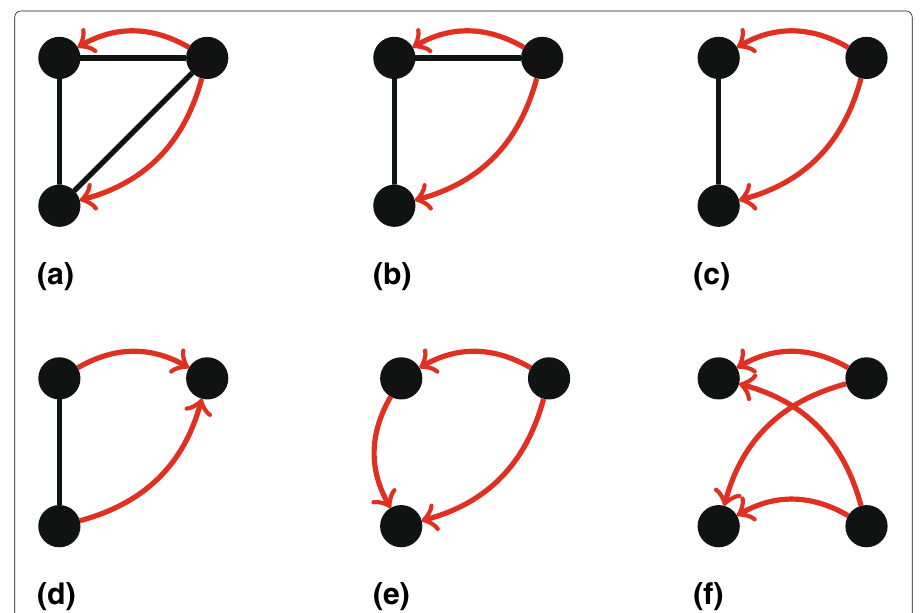
Fig. 7 Highlighted motifs of size 3 and 4. Values of r and c denote respectively ratio and concentration, cf. the “Motif evaluation metrics” section. a Motifofsize3. r = ∞ , c = 0.945%, b Motif of size 3. r = 1032, c = 0.118%, c Motifofsize3. r = 1170, c = 0.805%, d Motifofsize3. r = 516, c = 0.059%, e Motifofsize3. r = 278, c = 0.418%, f Motif of size 3. r = 2024, c =